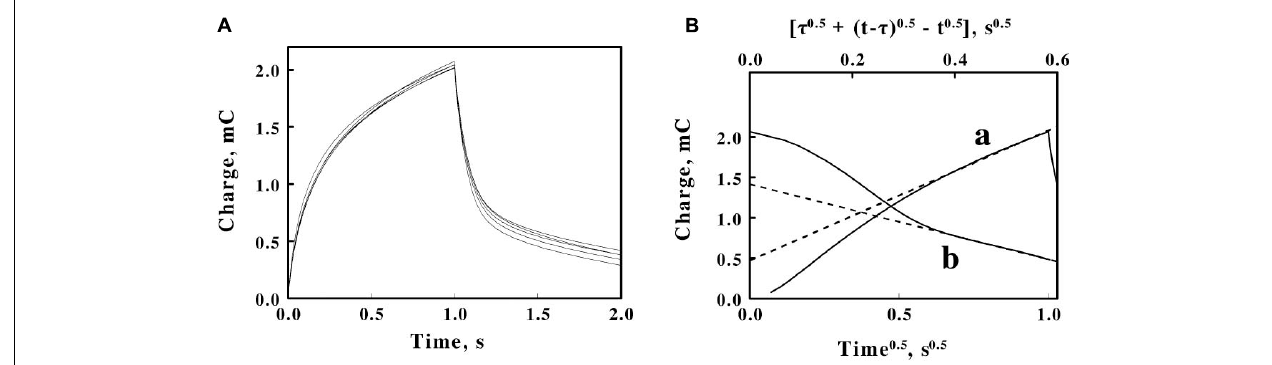
FIGURE 5 | Double potential step chronocoulometry on suspensions of F. acidiphilum in sulfuric acid, pH 1.5. (A) Charge vs. time responses obtained with 5 suspensions of cells: 0.48, 0.96, 1.44, 1.92, and 2.4 × 10 9 cells/ml. Each experimental curve of the charge as a function of time represents the mean of five individual determinations whose values varied by less than 1% among the five measurements. The increase in charge is a reduction step; the subsequent decrease in charge is an oxidation step. All 5 voltammograms are essentially superimposable. (B) Representative Anson plots for the reduction ( curve a, lower abscissa ) and the oxidation ( curve b, upper abscissa ) potential steps obtained using 1.44 × 10 9 cells/ml, showing both the charge values ( solid curves ) and the slopes ( dashed lines ) used to characterize the latter portions of the charge curves; t and τ represent the time since the start of the measurement and the duration of the first potential step,